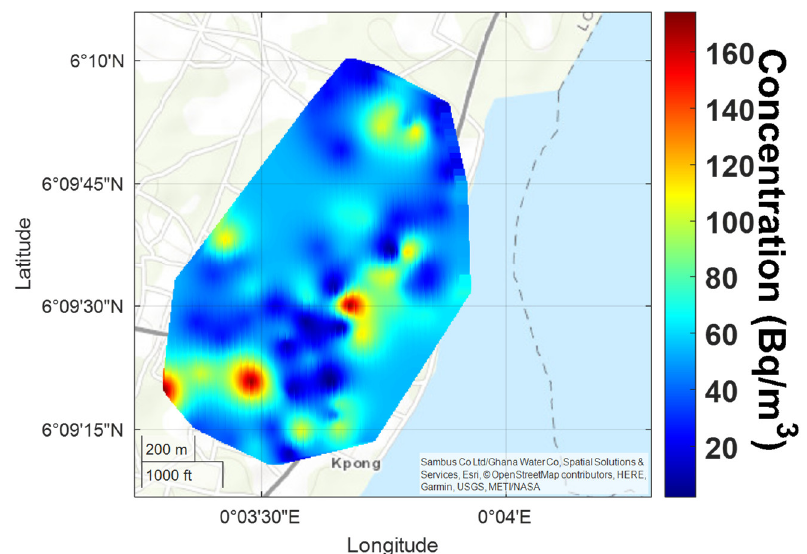
Figure 7. Kriging map obtained with the Gini method for 96 measurement points on the Kpong,